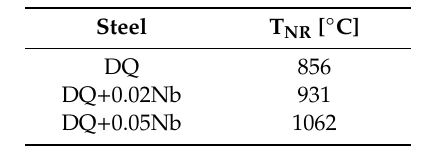
Figure 7. Thermo-Calc simulations under equilibrium conditions for ( a ) DQ, ( b ) DQ + 0.02Nb and ( c ) DQ + 0.05Nb steels. Table 4. Calculated non-recrystallization temperatures (T NR ) of the investigated